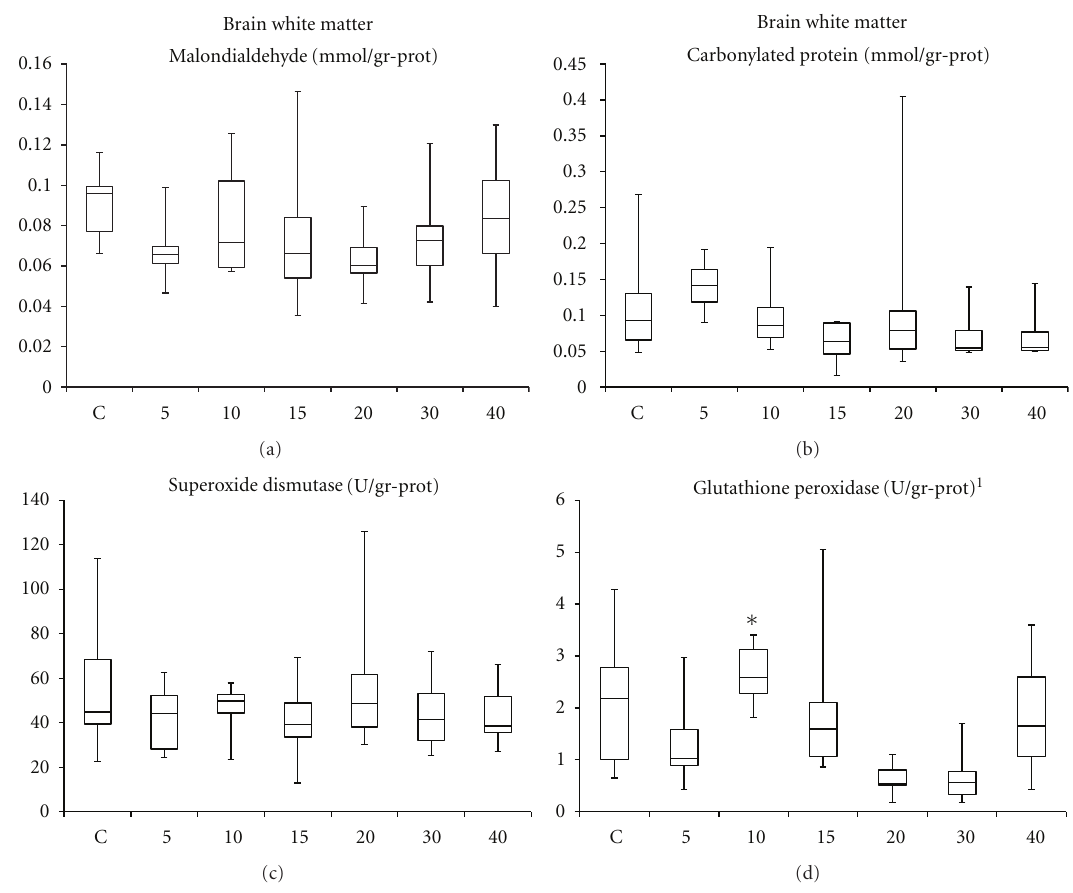
Figure 2: Oxidation products and antioxidant enzymes measured in the white matter of the brain. C: control group; numbers on the x -axis stand for the HBO 2 session number of the groups. One-way ANOVA : 1 P = 0 . 001. Bonferroni : ∗ P = 0 . 005 and P = 0 . 006 versus 20-, and 30-session HBO 2 groups, respectively. No significant variations compared with the control group were